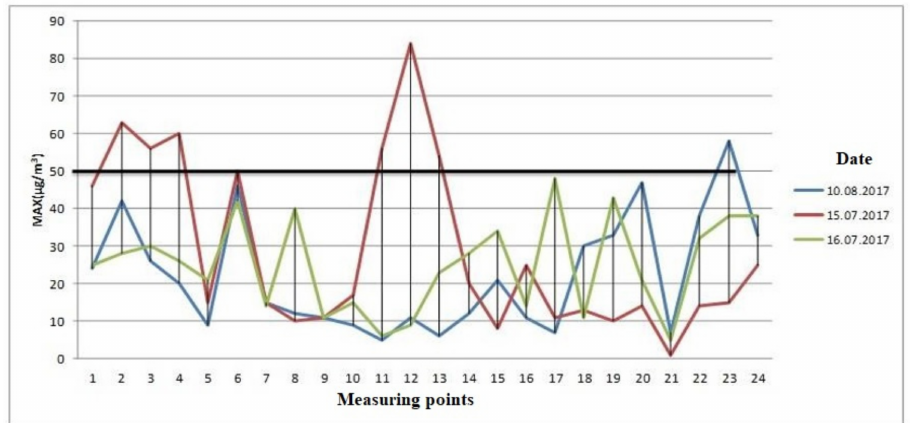
Figure 10. PM 10 maximum distribution